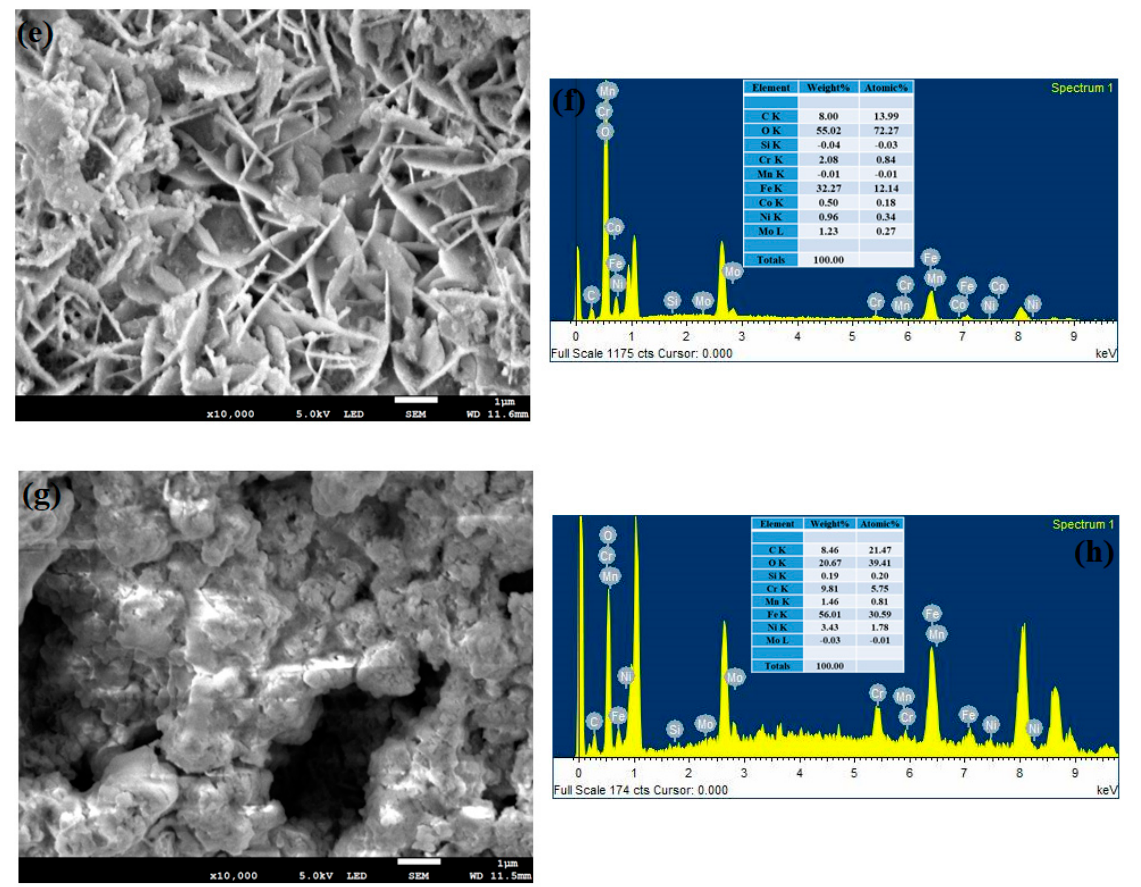
Figure 7. FESEM and EDS spectra of the corroded substrate samples treated at ( a , b ) 0 h ( c , d ) 18 h, ( e , f ) 42 h and ( g , h ) 70 h.